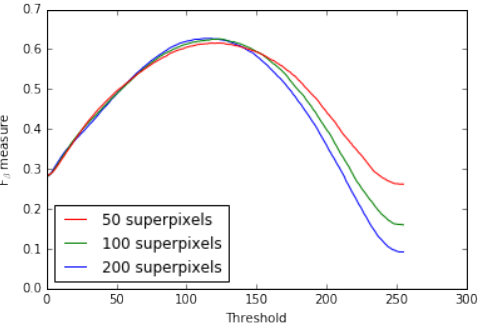
Figure 20. F β measure model’s curves for 50, 100, 200 superpixels (ECSSD